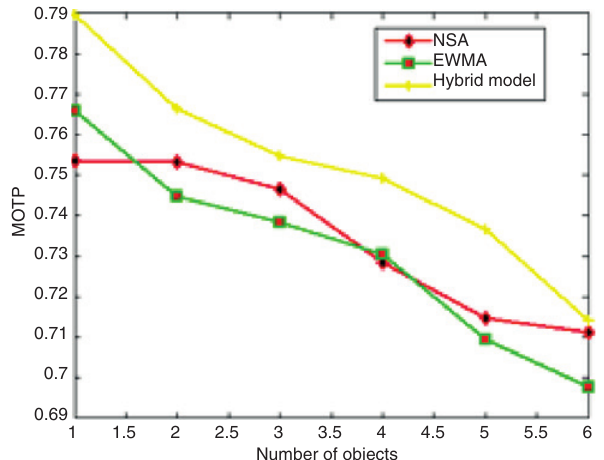
Figure 7: Performance Analysis of Object Tracking in Video